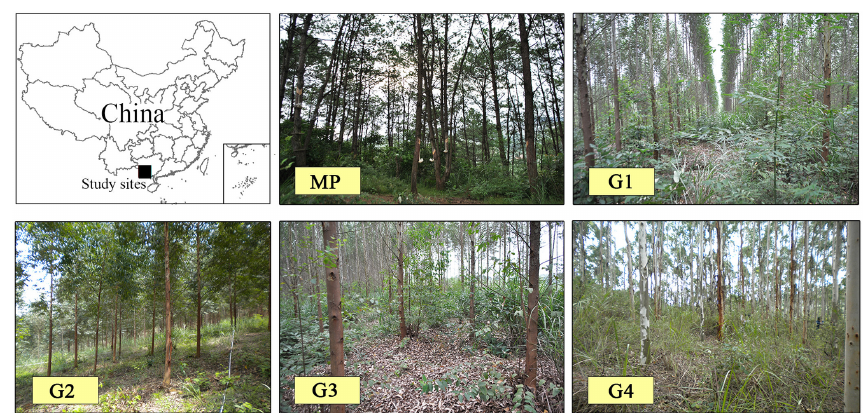
Figure 1. Study site and pictures of the Pinus and the successive Eucalyptus plantations. MP, G1, G2, G3 and G4 refer to the Pinus plantation and the first, second, third and fourth generation Eucalyptus plantations,